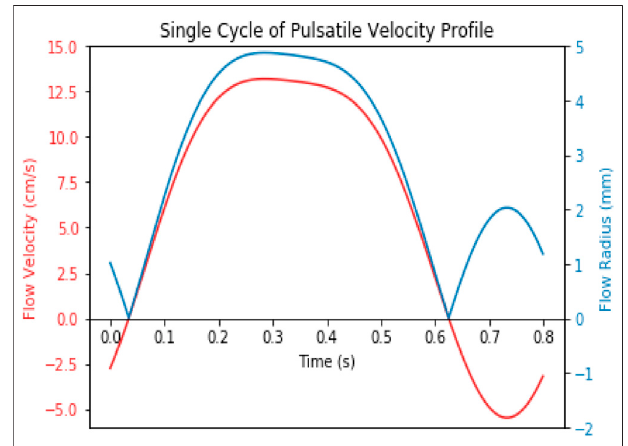
FIGURE 1 | Flow velocity in the CFV compared with fl ow radius during one heartbeat